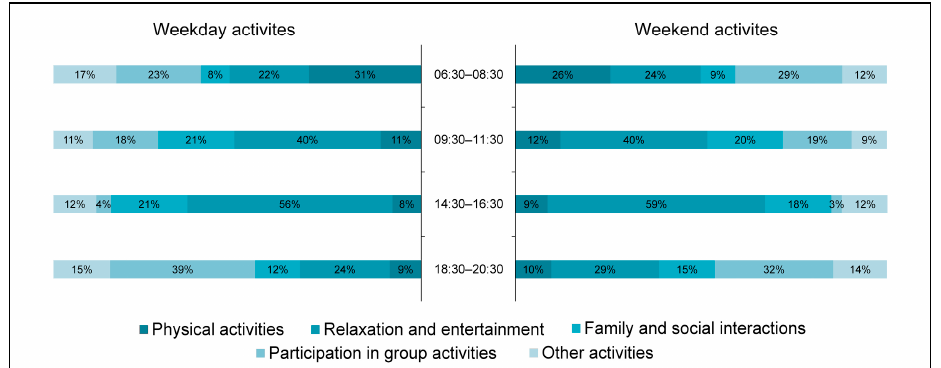
Figure 6. The composition structures of the five park use categories across the four periods on weekdays and weekends.